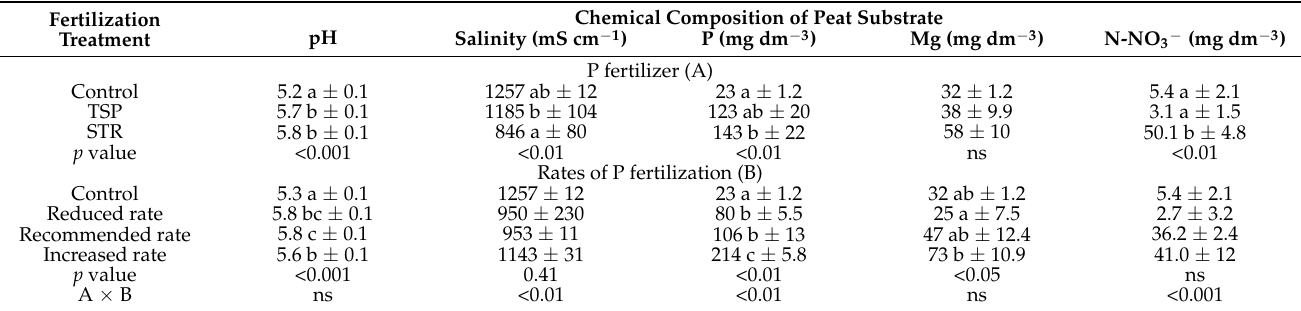
Table 4. Effect of STR fertilization on P, Mg and nitrate (N-NO 3 − ) content in peat substrate. Fertilization Treatment